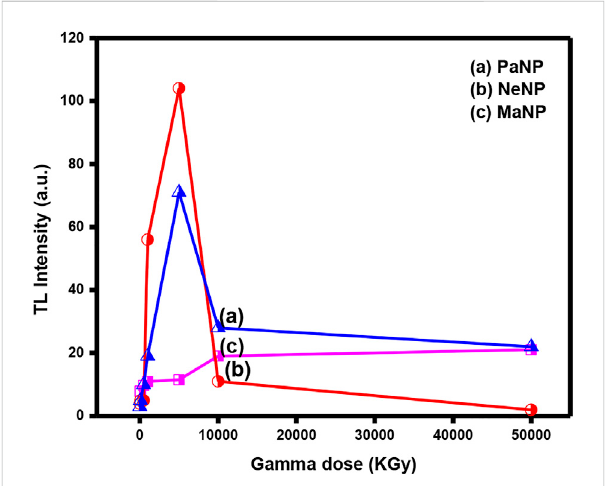
FIGURE 7 Variation of TL intensity with gamma dose in PaNP, NeNP, and